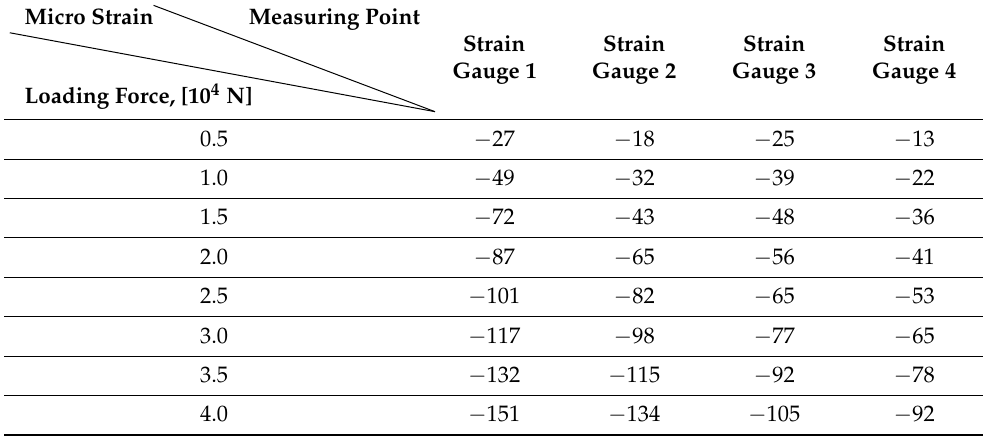
Figure 4. Deformation of Wedge Tooth under Longitudinal Load. Table 3. The strain values of each measuring point are under different loading force of 75 ◦ three-tooth wedge